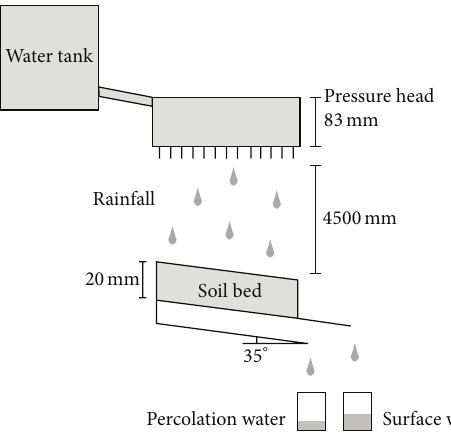
Figure 5: Schematic design of the artificial rainfall test.